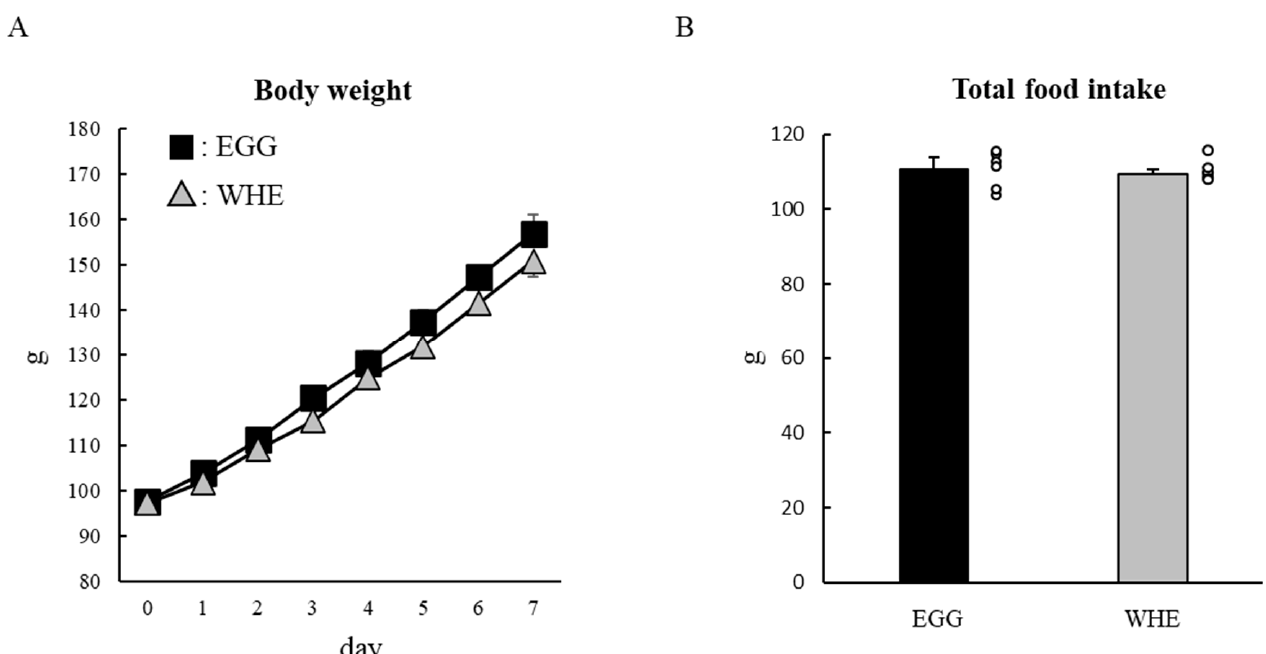
Figure 4. Chronic effect of each protein feeding on body weight and food intake (during 7 days). Rats were assigned to either an egg white, or whey protein diet group, and were maintained under ad libitum feeding for 7 days without clenbuterol administration. Bodyweight ( A ) and food intake were measured daily. Total food intake ( B ) was the sum of consumed food during 7 days. The dots beside bars indicate individual value. Values are means ± SE ( n = 5). EGG: egg white protein, WHE: whey protein. Different superscript represents statistical differences among groups.